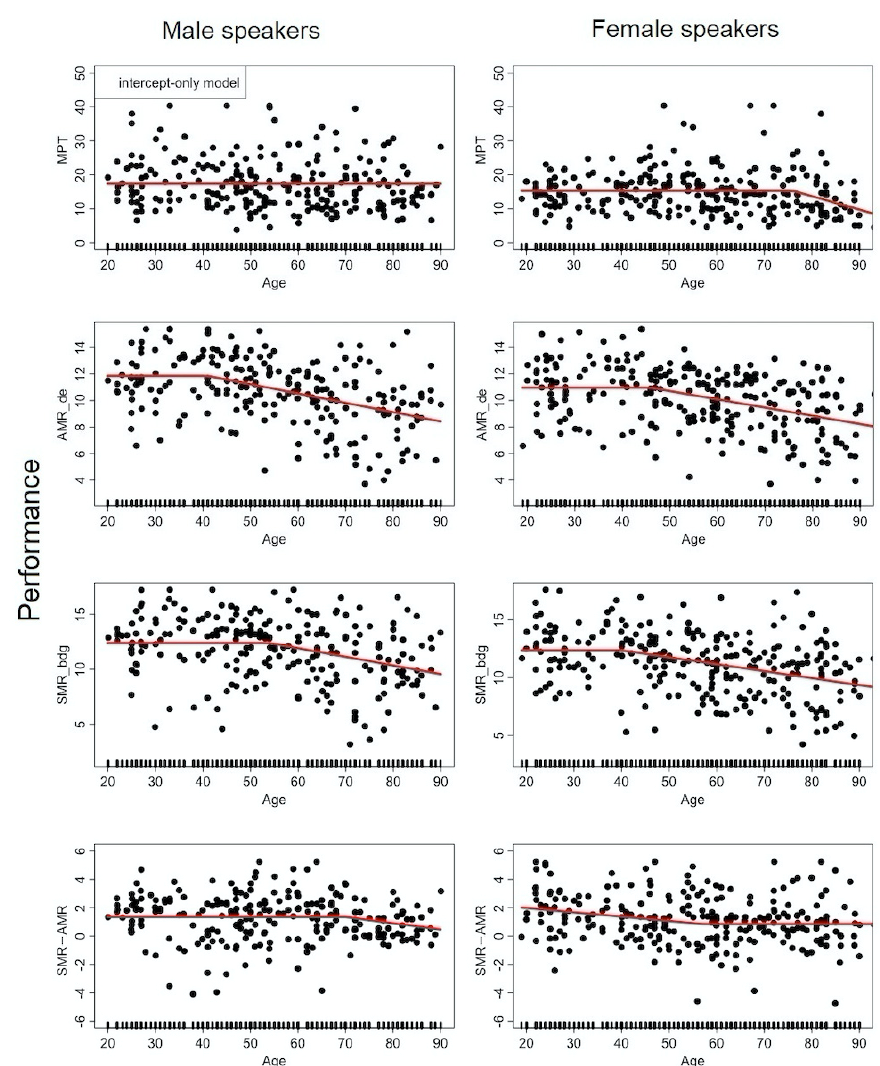
Figure A5. Dot plot of each descriptor ( y -axis) capturing aspects of the PERFORMANCE dimension as a function of age ( x -axis) for the male ( left ) and female ( right ) speakers. The hinge function of the MARS model is represented by the red curve. Each dot corresponds to a speaker. Table A1. Principal components of the PCA analysis, for female speakers (left) and male speakers (right).